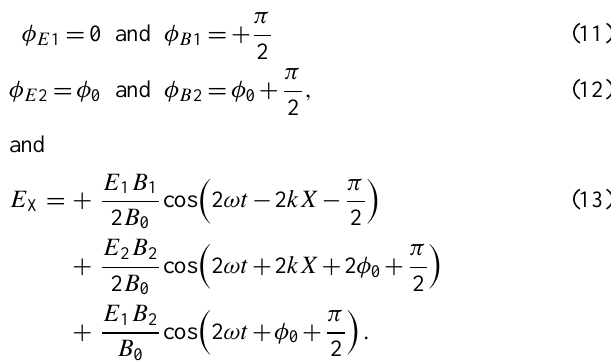
Fig. 8. AWC011. Temporal stack plot of the longitudinal electric field E X (X,t)